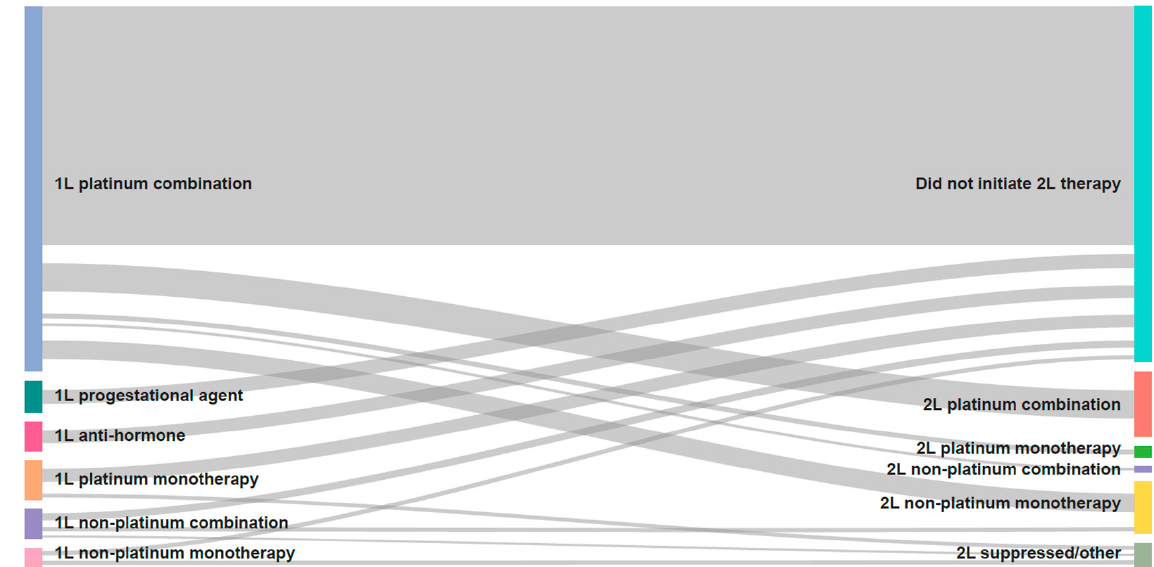
Figure 1. Distribution of first-line to second-line therapy across all patients. Sankey diagram show- ing the distribution of first-line to second-line therapy across all patients. The diagram indicates that most patients did not initiate second-line therapy.